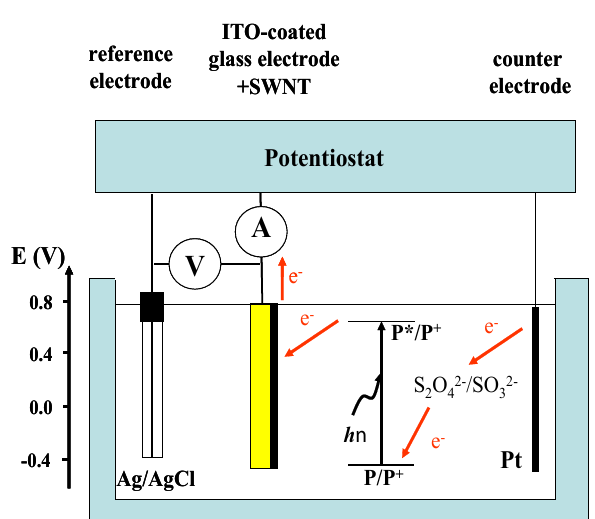
Fig. 4. Possible arrangement of solar battery created by using car- bon nanotubes and RCs. RCs are bound to single walled carbon nanotubes attached to ITO electrode. Light excitation generates charge separation in the RCs and the excited electron is pumped in the SWNT/ITO electrode. The electrical circuit is closed by mediating the electron flow between the Pt-electrode and the RC by dithionate. The redox potential is indicated versus stan- dard hydrogen electrode (SHE)